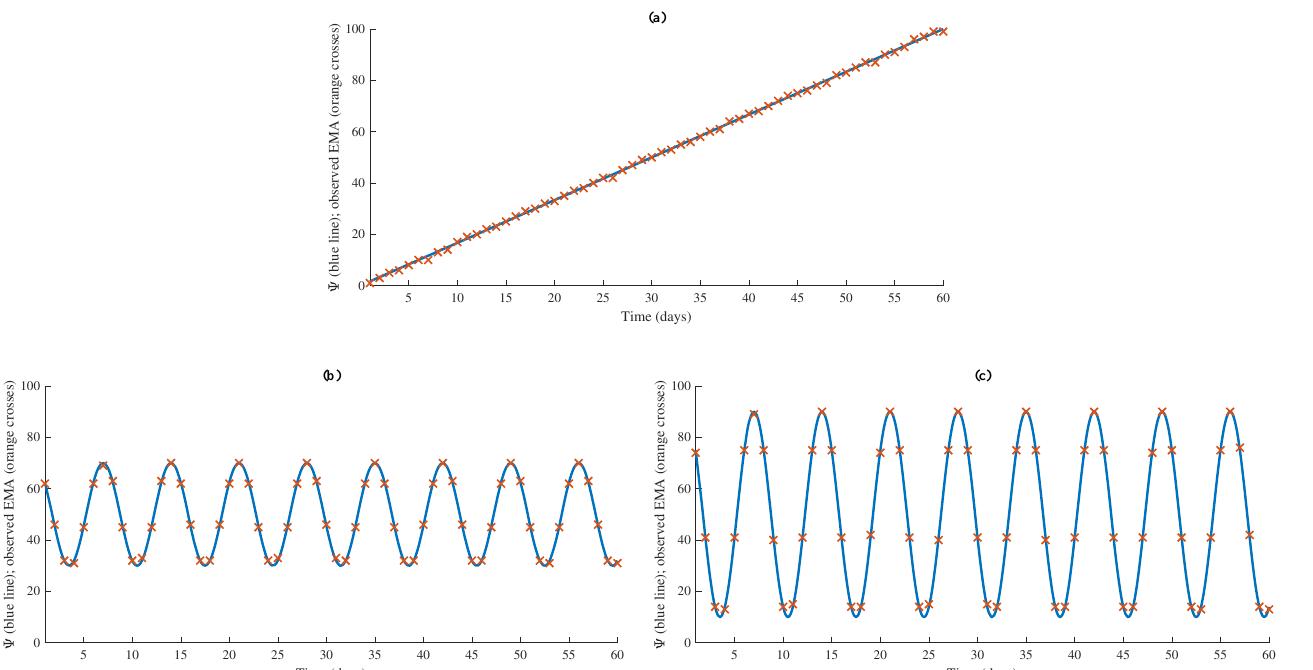
Figure 2. One random realization in the favorable scenario. ( a ) Linear function. ( b ) Cosine function with amplitude 20. ( c ) Cosine function with amplitude